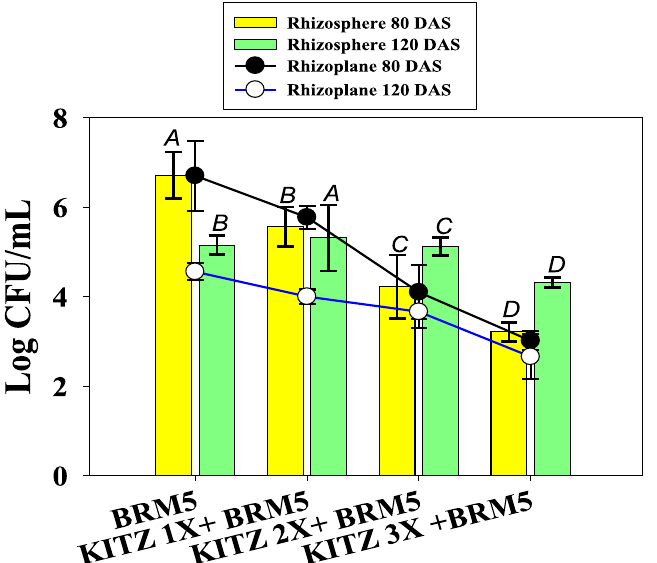
Figure 9. Rhizoplane and rhizosphere colonization in the presence of different concentrations of kitazin at two different seeding stages (80 and 120